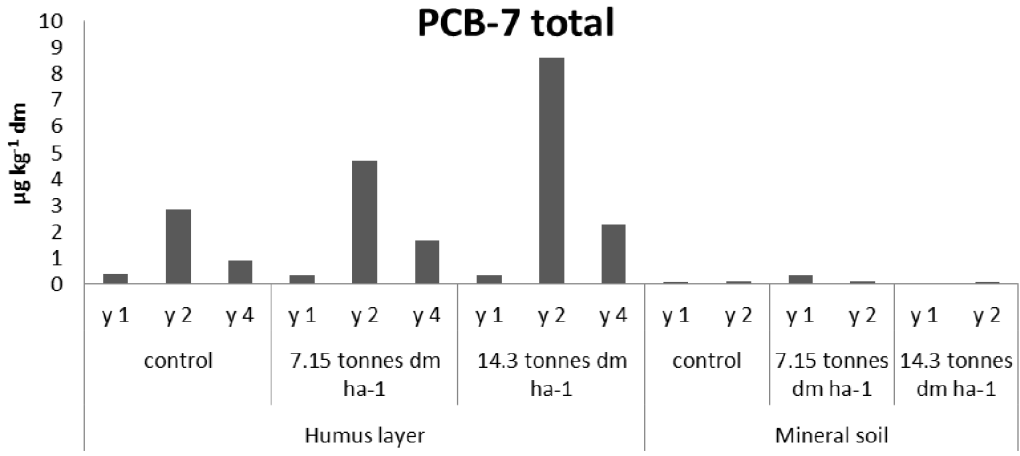
Figure 3. PCB-7 total levels in the small-scale experimental sites fertilized by hand (L1).